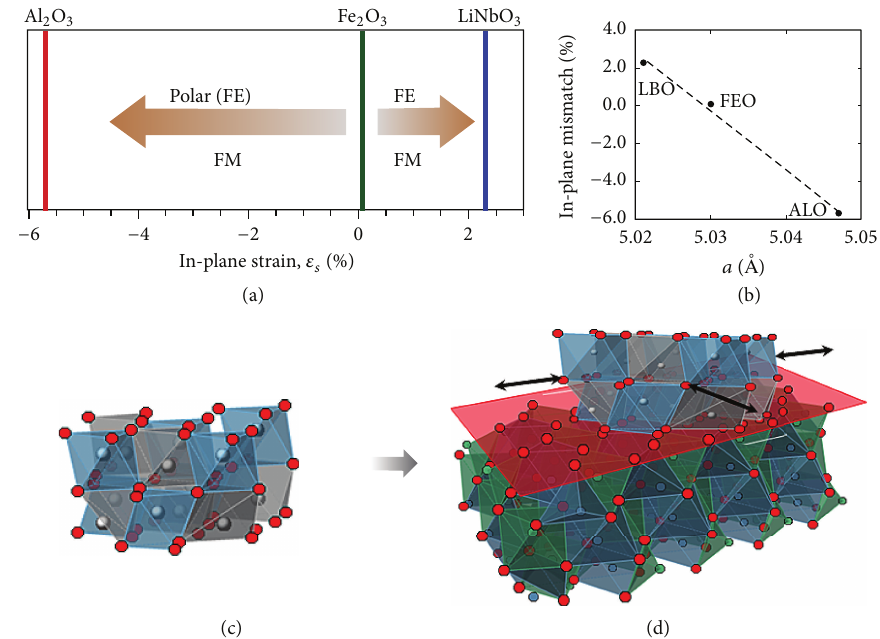
Figure 1: (Color online) Predicted effect of in-plane strain on NiTiO 3 exerted using epitaxy. (a) Schematic epitaxial phase diagram of NiTiO 3 strained from 6% (in-plane compression) to 2.5% (in-plane tension). Regions with polar/ferroelectric (FE) and ferromagnetic (FM) behavior are shown. (b) Lattice parameter (in-plane) versus strain from mismatch for the three substrates used in this study. (c) Crystal structure of unstrained bulk NiTiO 3 in the desired R3c structure. Grey octahedra: NiO 6 , blue octahedra: TiO 6 . (d) Schematic of the in-plane straining (compression/expansion) of thin-film NiTiO 3 on the substrate (here, the structure of the LiNbO 3 substrate is shown, green octahedra are NbO 6 , blue octahedra are LiO 6